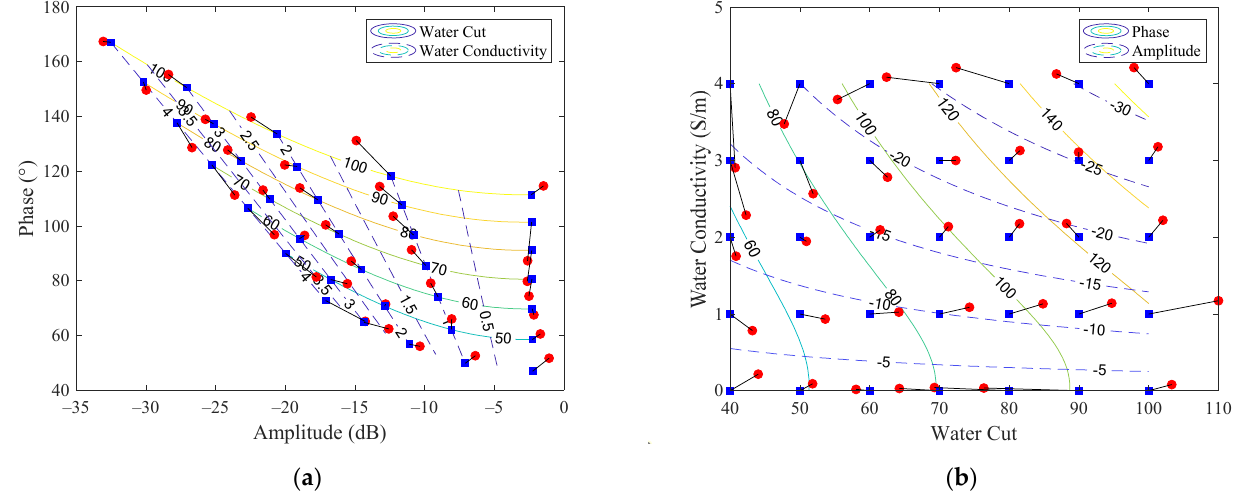
Figure 6. The experimental results (red circles) and theoretical predictions (blue squares) of the 55 test points and the contour maps showing the relationship between ( ∆ A , ∆ φ ) and ( α w , σ w ) predicted by the theoretical model: ( a ) water cut α w and conductivity σ w as functions of microwave phase ∆ φ and amplitude ∆ A , with different contour color lines denoting different α w (solid) and σ w (dashed) values; ( b ) microwave phase ∆ φ and amplitude ∆ A as functions of water cut α w and conductivity σ w , with different contour color lines denoting different ∆ φ (solid) and ∆ A (dashed) values. The numbers on each contour color line denote the values of α w , σ w , ∆ φ or ∆ A , and the length of the black connecting-lines between the red circles and blue squares denote the measurement error values. The measurement errors ( e wlr , e sig ) of the iteration algorithms are also shown in Figure 7, where the central black line denotes the ideal case with zero error; the upper and lower red lines denote the 5% error range, and the upper and lower blue lines denote the 10% error range. From Figure 7 it can be noted that most of the water cut estimates are within the 5% error range whereas most of the water salinity measurements are within the 10% error range. Therefore, the accuracy of the iteration algorithm and microwave sensor is satisfactory for water-continuous flow conditions.